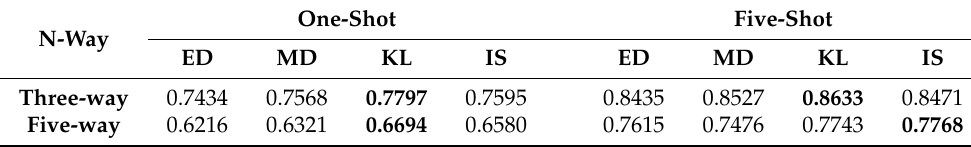
Table 3. Results for Experiment II: prototypical networks on adult stage subset. One-Shot Five-Shot N-Way ED IS